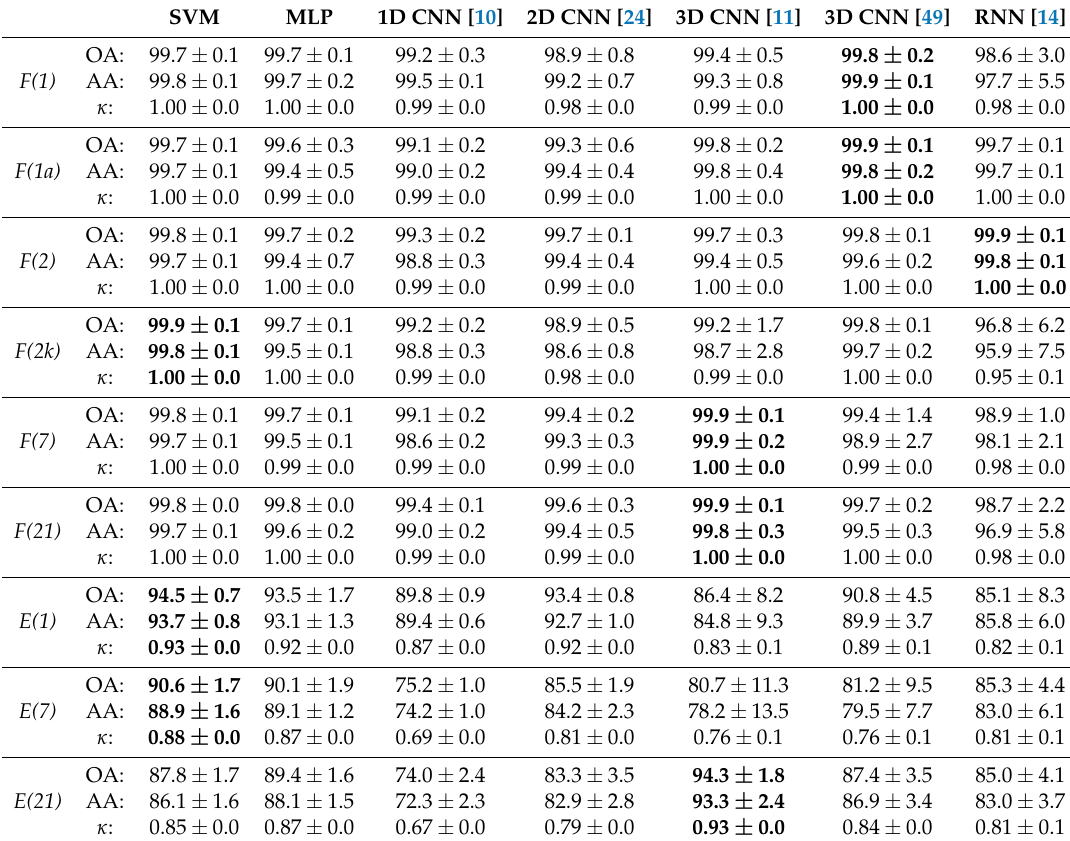
Table 1. The results of experiments for the transductive scenario (HTC). In consecutive rows values of Overall Accuracy (OA, %), Average Accuracy (AA, %) and Cohen’s kappa coefficient ( κ ) are presented for each image. The best OA scores are